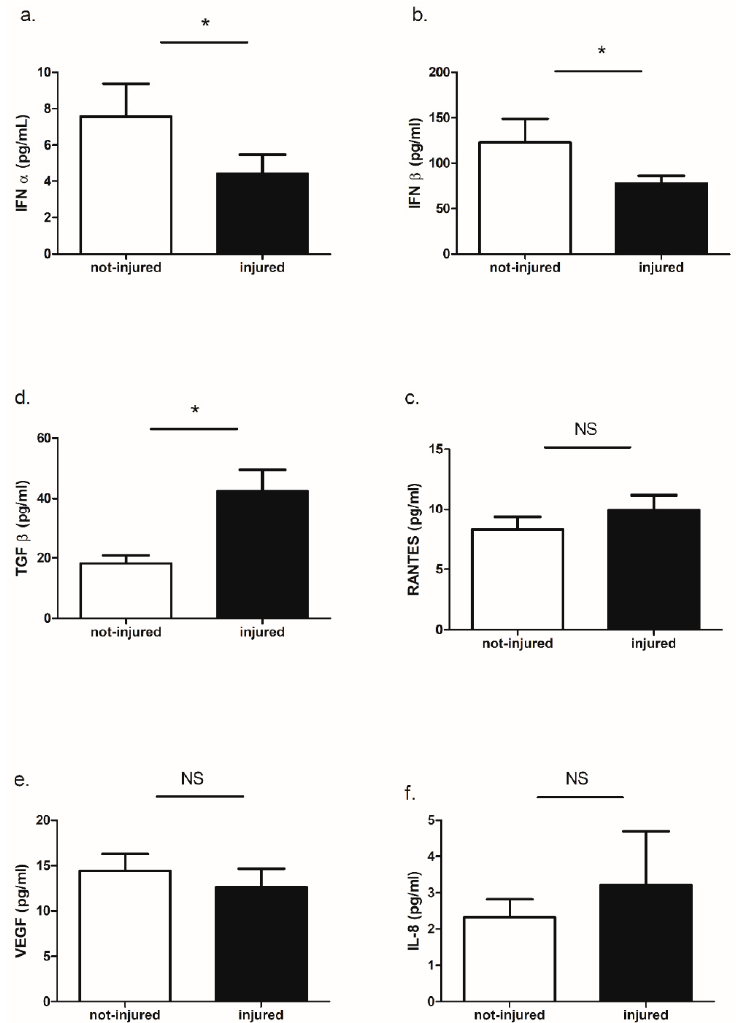
Figure 10. Cytokines protein release in wounded and not-wounded epithelial cells. ( a ) IFN- α ; ( b ) IFN- β ; ( c ) RANTES; ( d ) TGF- β ; ( e ) VEGF; ( f ) IL-8; * p < 0.05; NS: no statistically significant